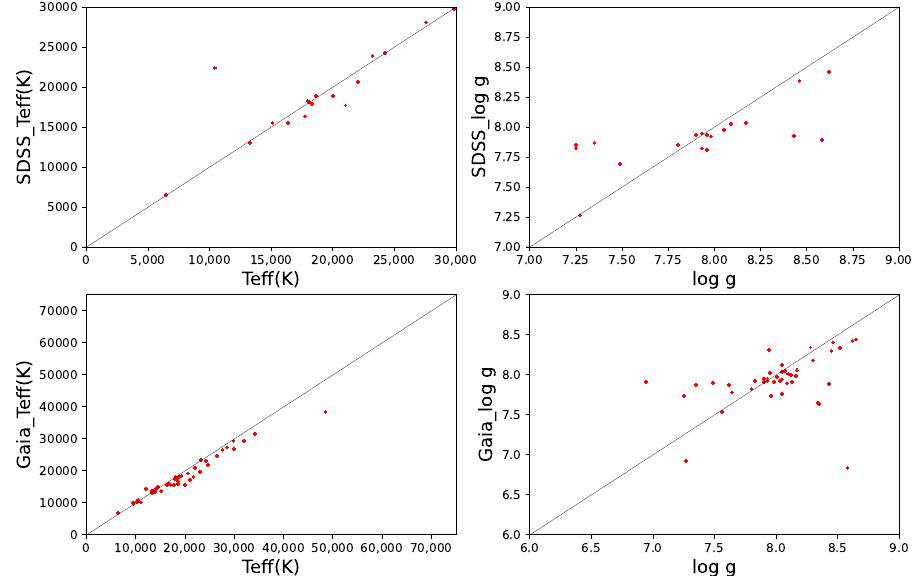
Figure 6. Comparison of the T ef f , log g of white dwarfs provided by Gaia and SDSS with our calculated T ef f , log g of white dwarfs. The black solid lines are unit slope relationships. Top panel: Comparison of the T ef f and log g we calculated with the T ef f and log g calculated with the SDSS. Lower panel: Comparison of the T ef f and log g we calculated with T ef f and log g calculated with